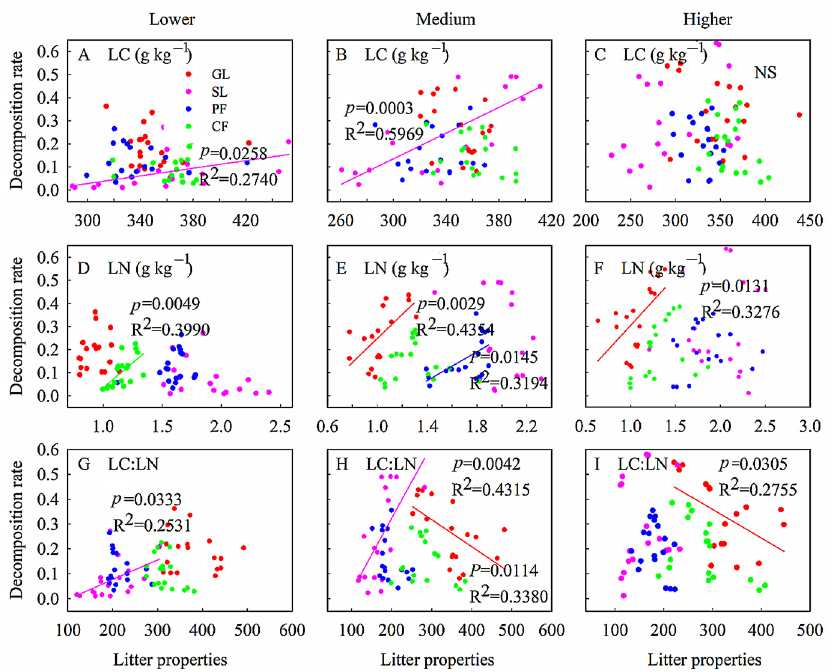
Figure 4. Correlation between LC, LN, LC: LN and litter decomposition rate. LC: litter carbon, LN: litter nitrogen. Lines not shown in the figure indicate no correlation ( p > 0.05). GL, grassland; SL, shrubland; PF, pioneer forests; CF, climax forests. ( A – C ) represent the correlation between litter decomposition rate and LC under lower water, medium water, and higher water treatments, respectively; ( D – F ) represent the correlation between litter decomposition rate and LN under lower water, medium water, and higher water treatments, respectively; ( G – I ) represent the correlation between litter decomposition rate and LC: LN under lower water, medium water, and higher water treatments, respectively.